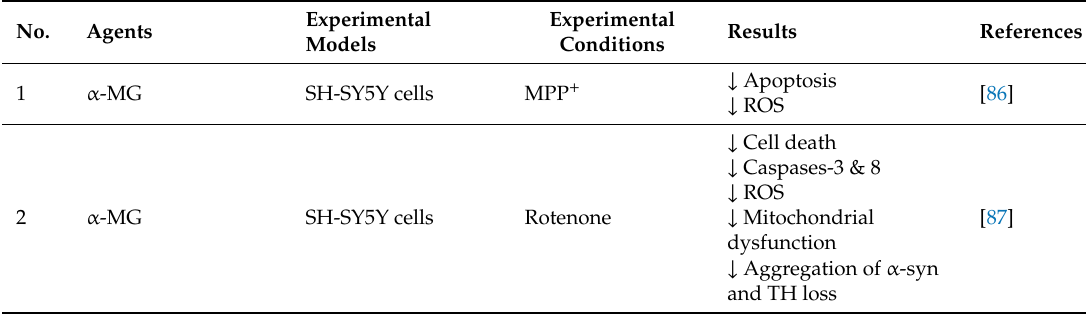
Table 2. Further mechanistic studies of α -MG, γ -MG, and other bioactive compounds or extracts from MP are required on both preclinical and clinical levels to probe their potential value in the management of PD. Table 2. Pharmacological e ff ects of α -mangostin and γ -mangostin in Parkinson’s disease models. Experimental Experimental No. Agents Models Conditions